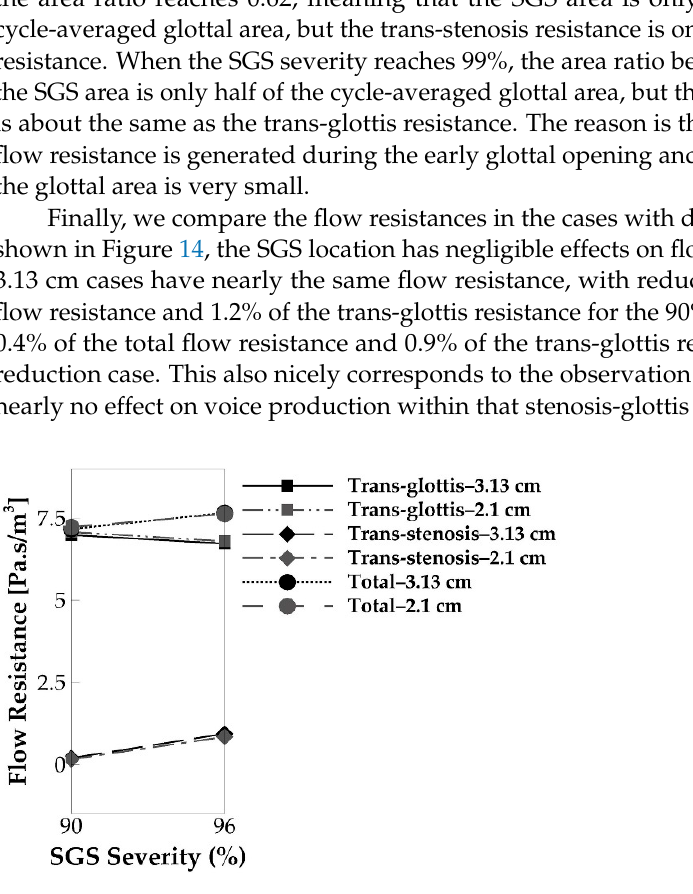
Figure 14. The cycle-averaged trans-glottis, trans-stenosis, and tract flow resistance of the 2.1 and 3.13 cm SGS distances for the 90% and 96% SGS severities.